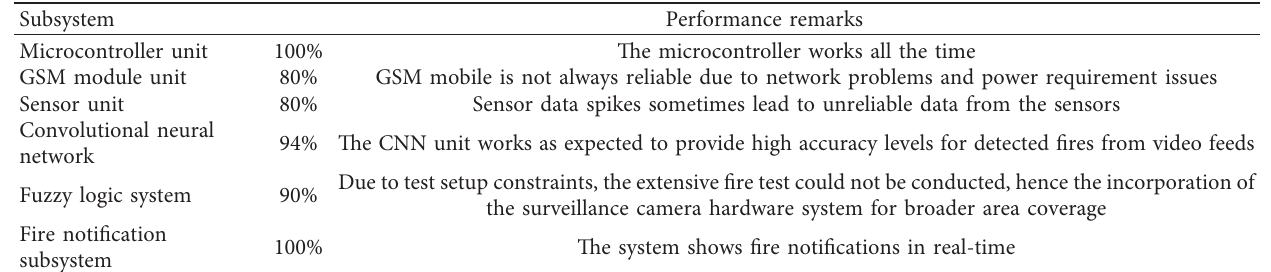
Figure 16: Graph of cross entropy against step size. Table 7: Performance evaluation of subsystem modules.